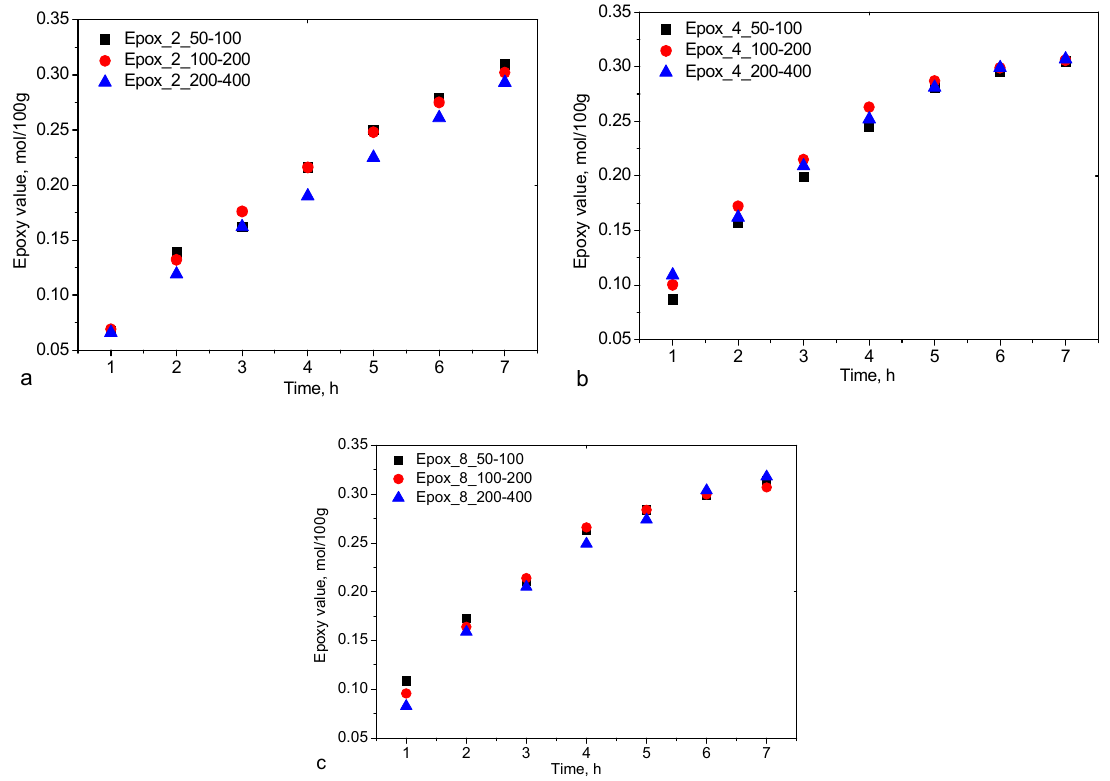
Figure 4. Influence of different grain size of ( a ) Dowex50 × 2, ( b ) Dowex50 × 4, and ( c ) Dowex50 × 8.